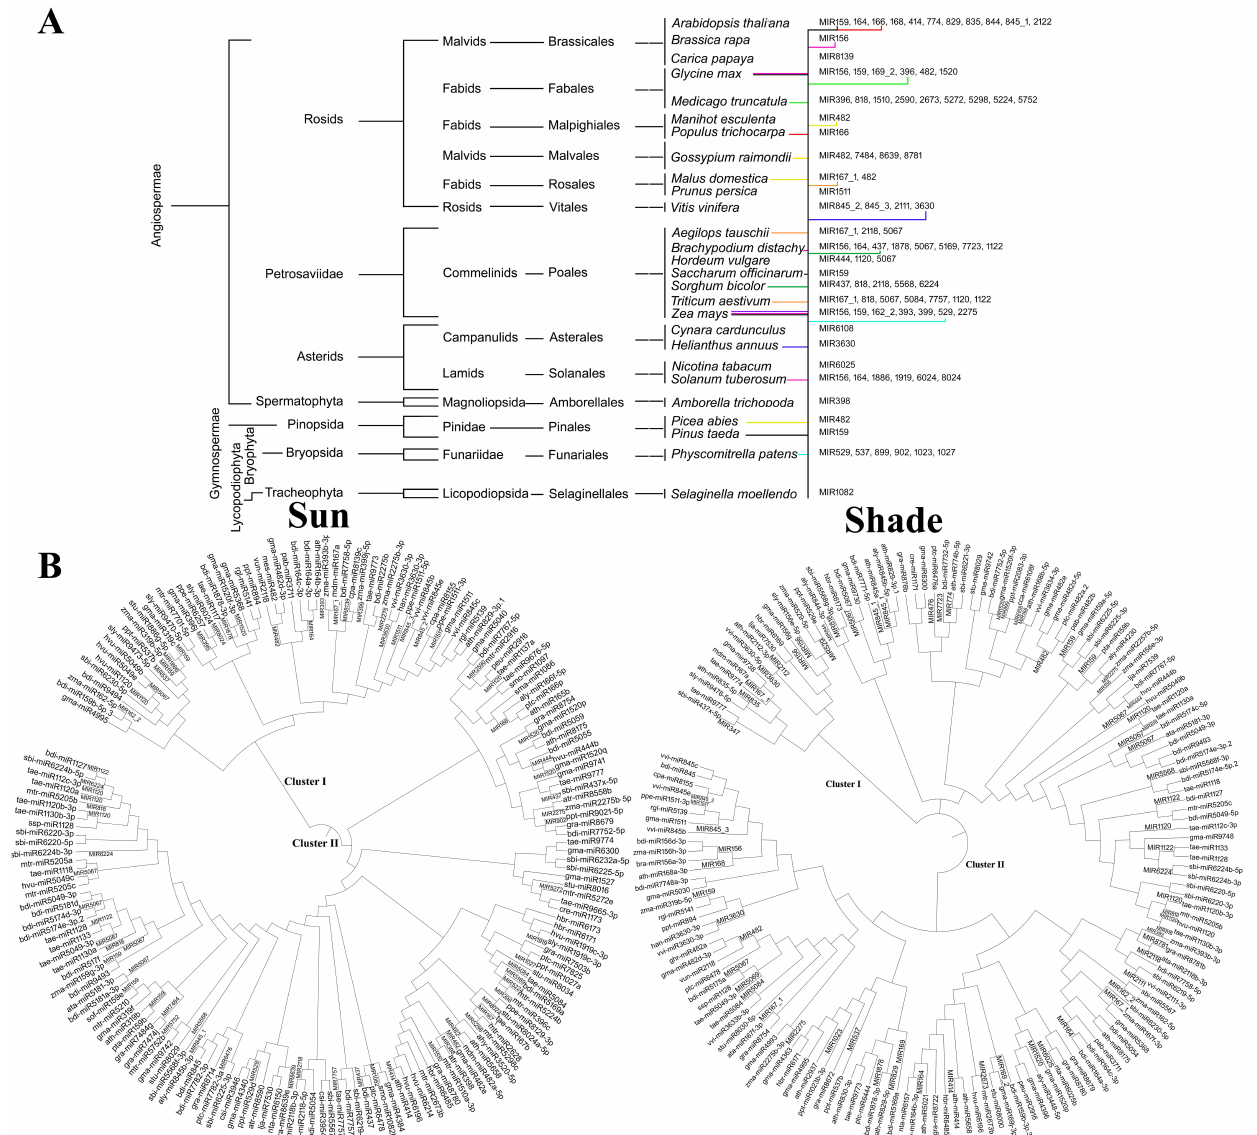
(Table S5). Furthermore, the MIR144 formed a subgroup with Arabidopsis thaliana . The MIR family MIR5067 showed the highest similarities with different species, i.e., 24 miRs (including T. aestivum , H. vulgare , A. tauschii, and B. distachyon ) (Figure 2A). According to the phylogenetic analysis (Figure 2A), A. thaliana (10), B. distachyon (7), T. aestivum (7), and Z. mays (7) shared maximum identity with rice miRNAs and were among the closest species, and the Selaginella melandasy species was the most related ancestor in relation to miR phylogeny. MIR529 was clustered with Physcomitrella patens , indicating the conserved phylogenetic relationship of the rice miRNAs with this species. The similarity analysis of the novel miRs for orthologues in other plants revealed only one hit, i.e., mireap-m0014-5p with the 5 (cid:48) TGTATGGCTCTGATACCAGCTCT3 (cid:48) sequence, the showed 100% identity (E value 0.002) with the Rehmannia glutinosa miR5139 belonging to miRNA family of ap-m0014- 5p (data not shown). However, considering the stability and no homology, we suggest that new species-specific miRNAs have recently evolved and been expressed at lower levels [59]. A list of MIR families and their rice miRNAs is presented in Table S6.